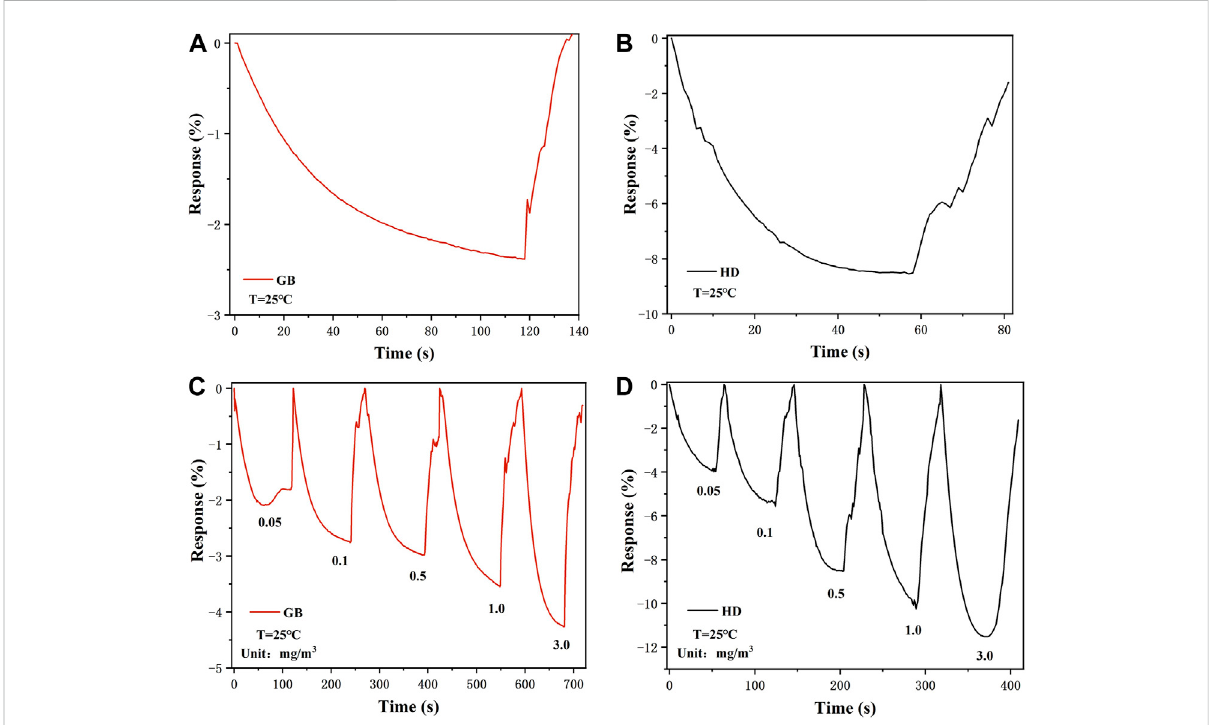
FIGURE 6 Response – recovery curve of the Nb-MoS 2 NSs-based gas sensor to 0.5 mg/m 3 (A) sarin and (B) sulfur mustard. Dynamic curves of exfoliated the Nb-MoS